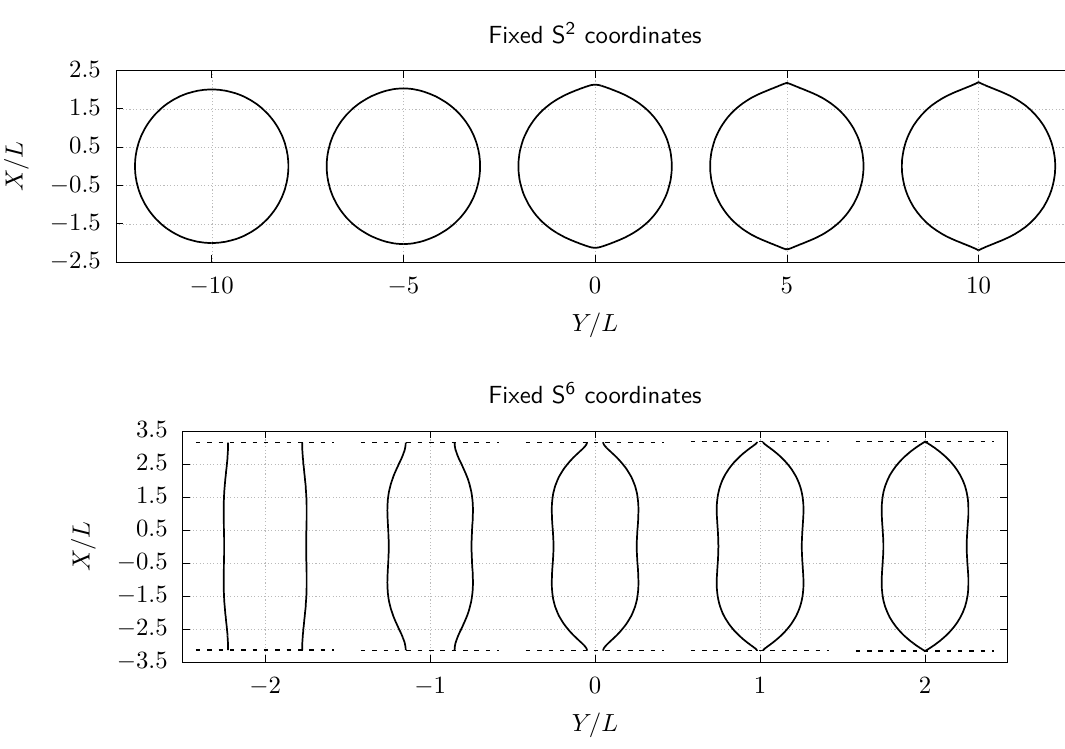
Figure 12. Embedding plots for fixed S 2 /S 6 coordinates of lumpy black holes in AdS 4 × S 7 with ‘ = 2 + . This family merges with a black belt with horizon topology S 3 × S 6